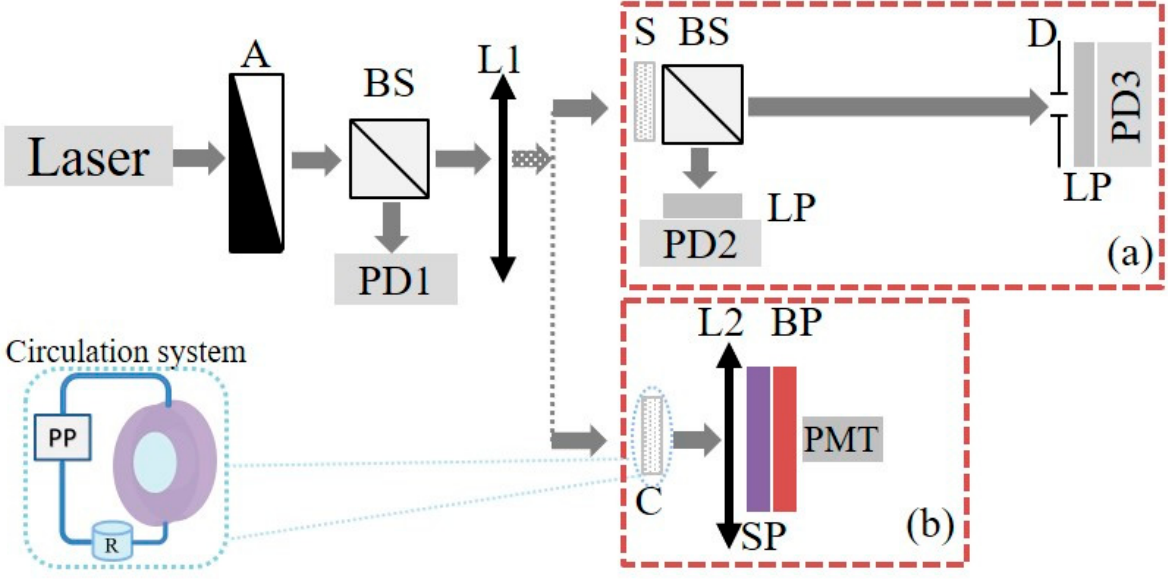
Figure 1. ( a ) Scheme of experimental setup for analysis of photoinduced variations of total and on-axis transmittance due to the self-action of the laser beam under ps pulsed excitation at 1064 nm; ( b ) experimental setup for interface scanning technique at TH. A—neutral density gradient filter; BS—beam splitter; L1, L2—focusing lenses; D—finite diaphragm (d = 2 mm); PD1, PD2, PD3—photodiodes; PMT—photomultiplier tube; LP—longpass filter; SP—shortpass filter; BP—bandpass filter; S—sample; C—flow cell; R—main reservoir; PP—peristaltic pump.